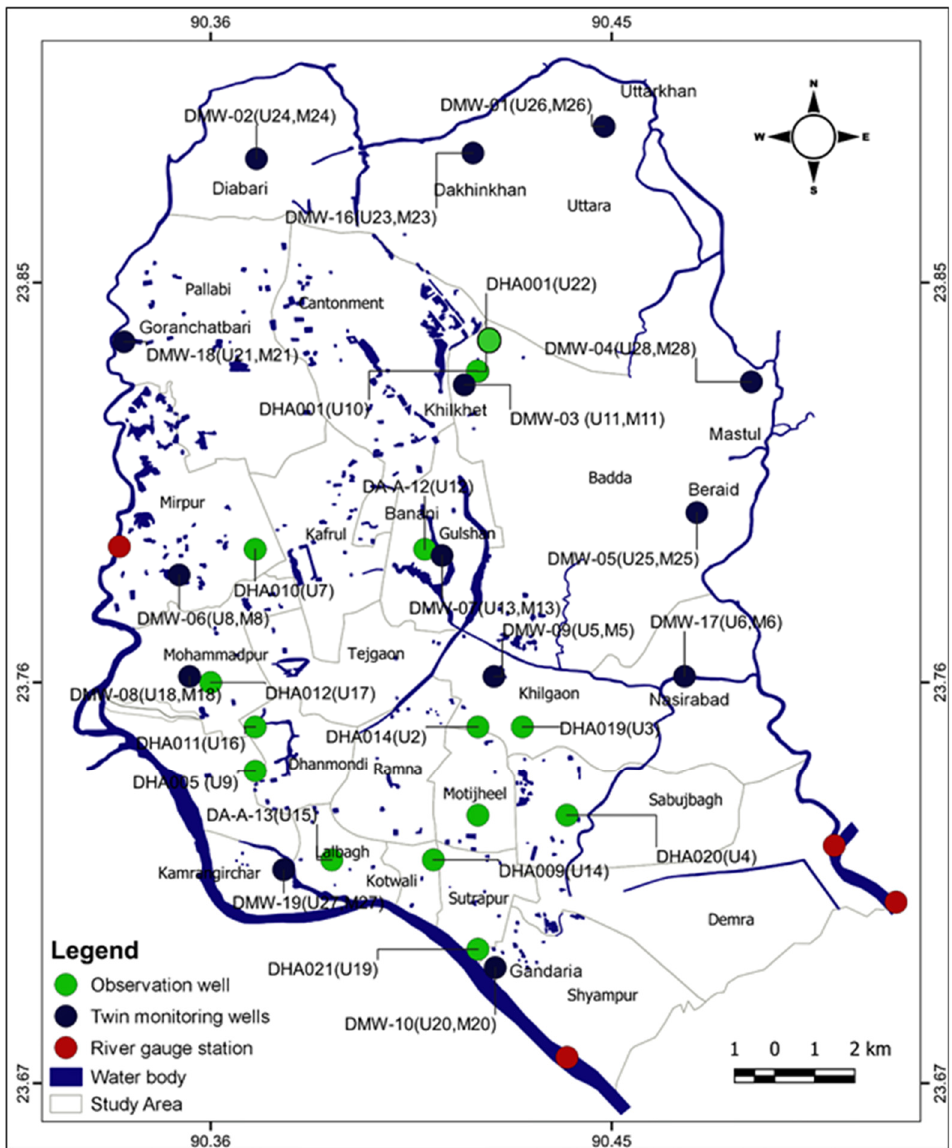
Figure 7. Location map of observation wells, twin monitoring wells and river gauge stations.